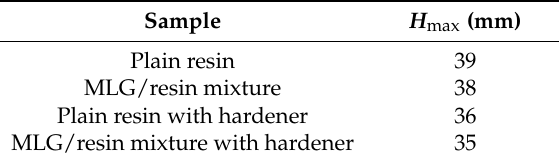
Figure 5. Variation of rise height H as a function of time of plain resin and of the MLG/resin mixture, with and without hardener. Table 1. Maximum rise height H max of the plain resin and of the MLG/resin mixture, with and without hardener.